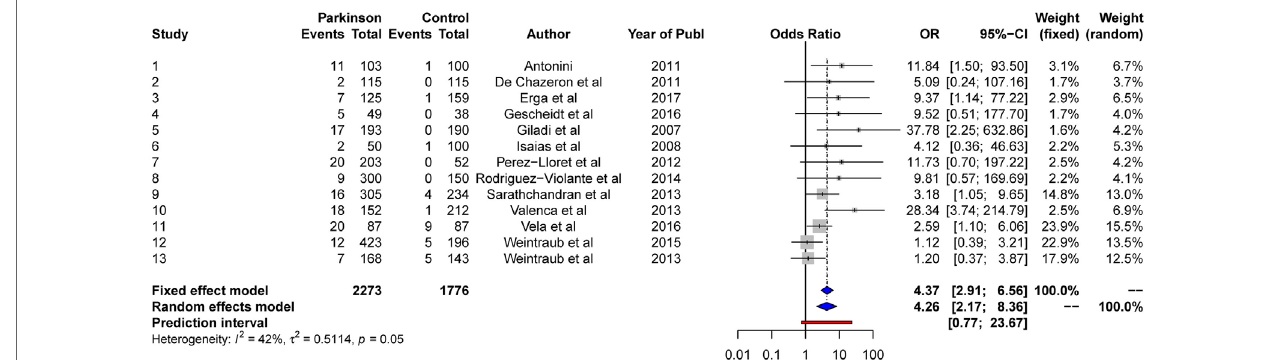
FigURe 6 | Forest plot for